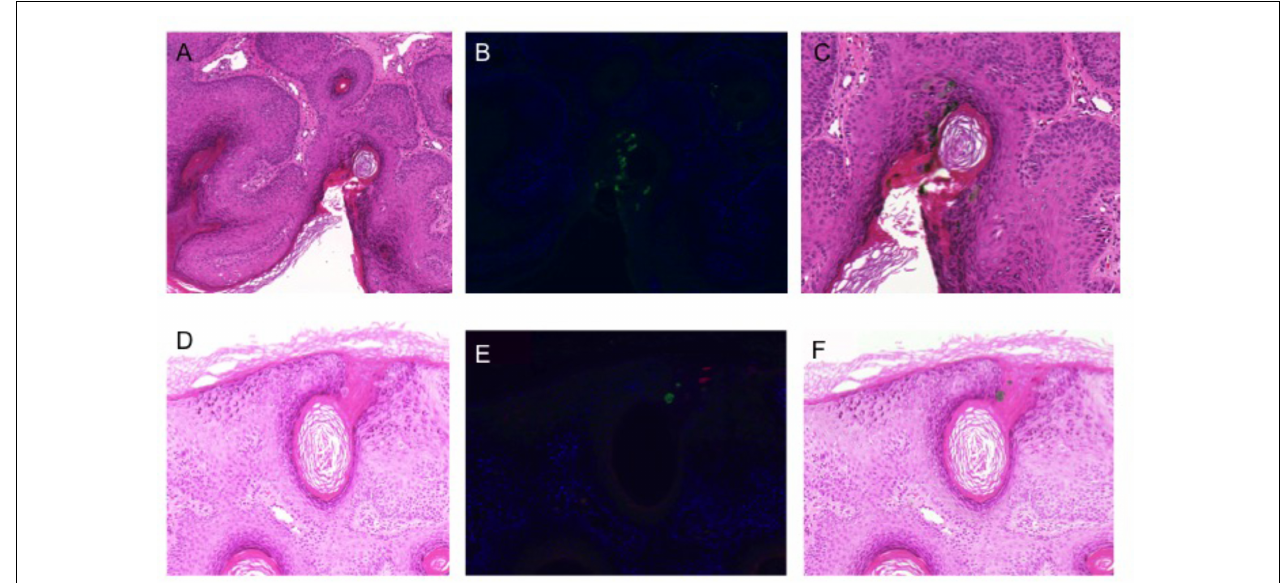
FIGURE 4 | Human papillomavirus immunohistochemistry. (A,D) Hematoxylin and eosin stained sections of 2 different areas of lesion V10 (strongly PCR positive for beta-PV types 8, 12, 76, 80, and alpha-PV 57); (B,E) double staining immunofluorescence with antibodies to the E4 protein of HPV8 (green) and HPV2/57 (red); (C,F) H&E stained sections overlaid with the images from immunofluorescence microscopy to identify cells with productive HPV